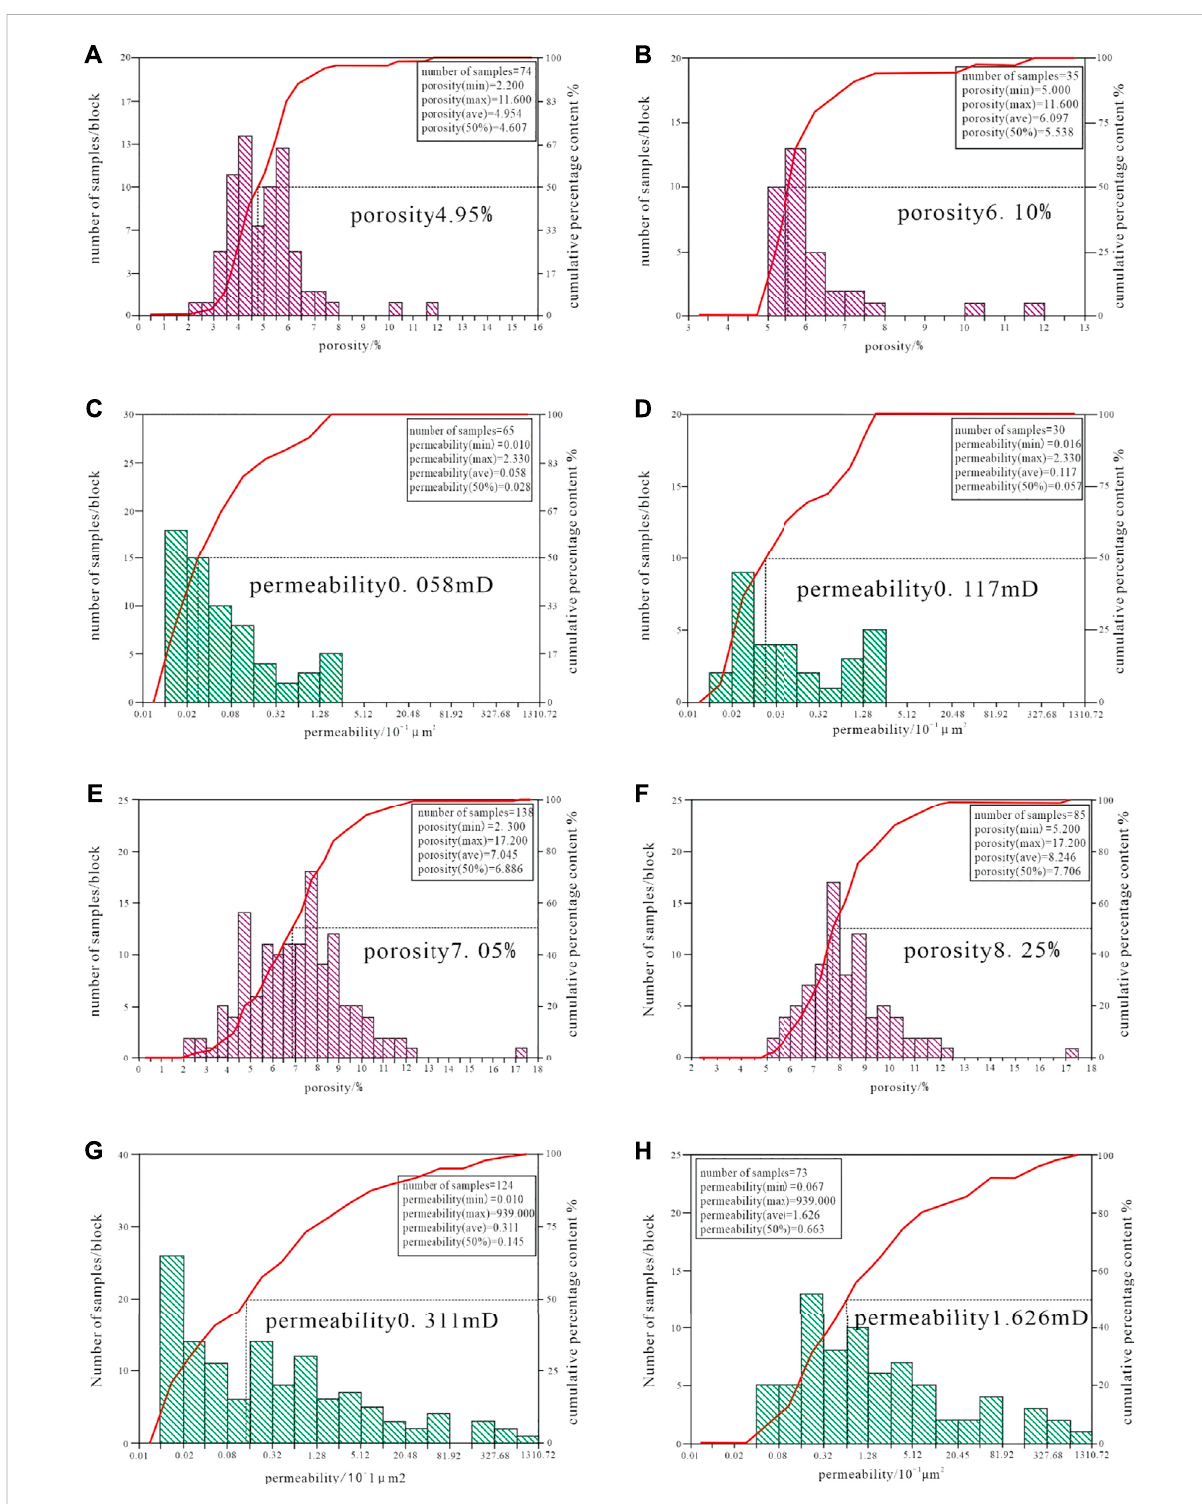
FIGURE 3 Porosity and permeability histograms of the Permian Upper Wuerhe Formation of Dinan 15 well block. (A,B) Porosity histogramof Section I,the Upper Wuerhe Formation; (C,D) Permeability histogram of Section I, the Upper Wuerhe Formation; (E,F) Porosity histogram of Section II, the Upper Wuerhe Formation; (G,H) Permeability histogram of Section II, the Upper Wuerhe